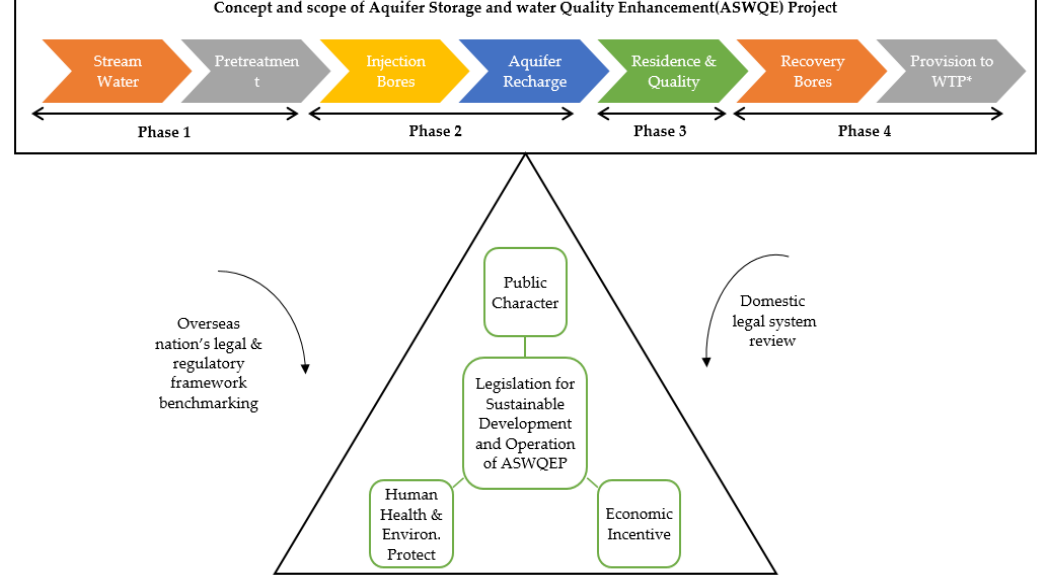
Figure 1. Concept and scope of the aquifer storage and water quality enhancement project (ASWQEP) and legislation requirements. WTP: Water Treatment Plant